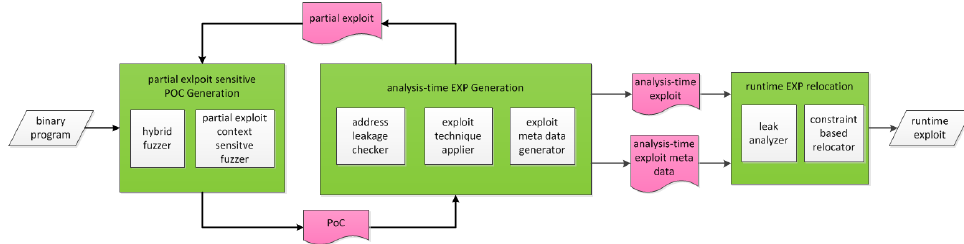
Figure 3. Overview of